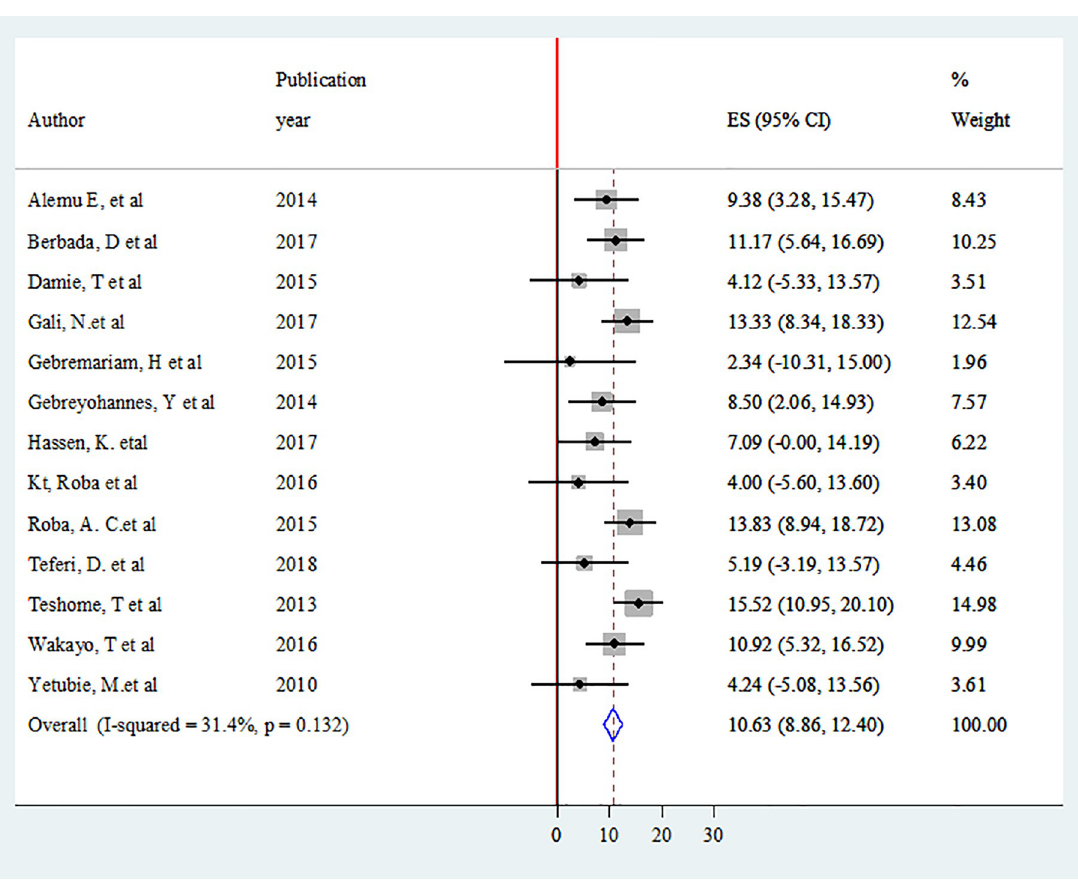
Fig 2. Forest plot of the pooled prevalence of adolescent overweight/obesity in